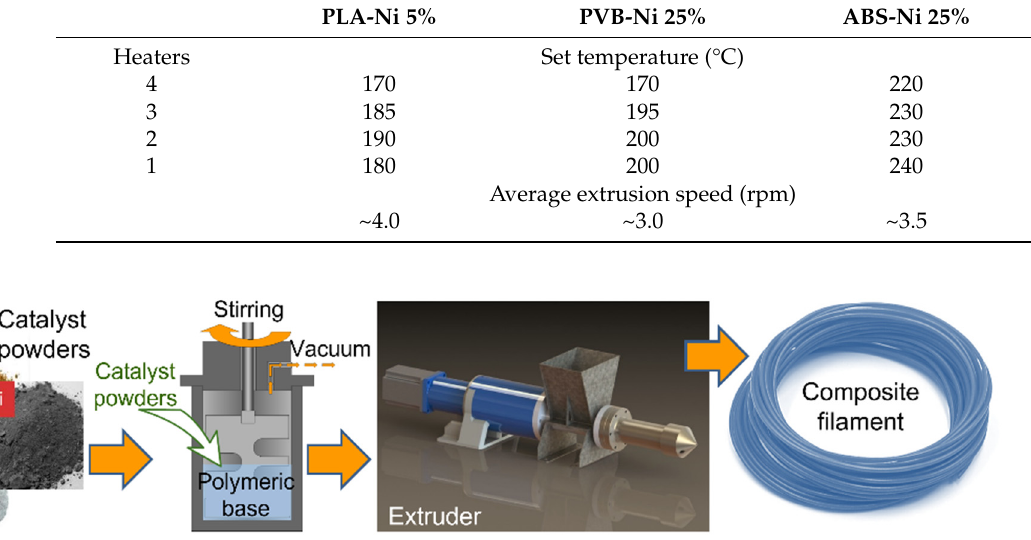
Figure 2. Fabrication route of new composite